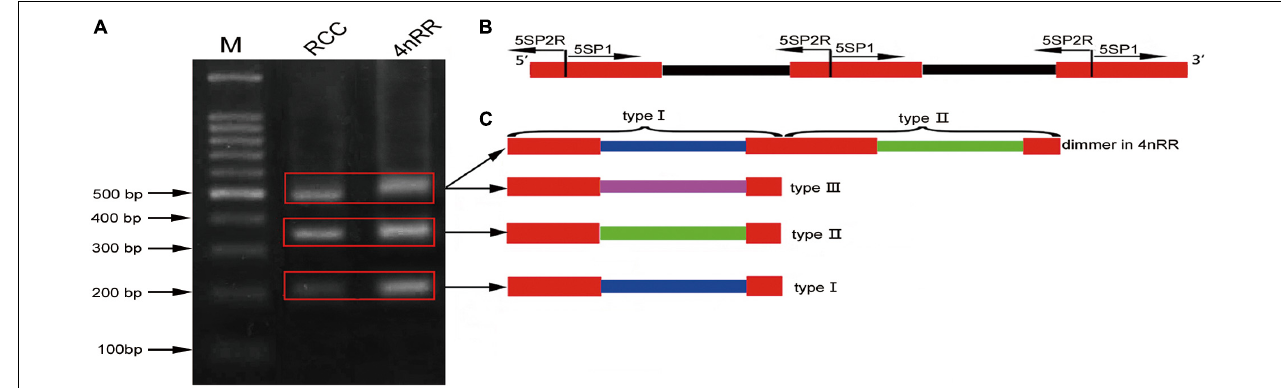
FIGURE 1 | DNA bands amplified from RCC and 4 n RR. (A) Using the primer pair 5S P1- 5S P2R, DNA fragments were amplified from RCC and 4 n RR. M, DNA ladder markers (100 bp increments); lane 1, three DNA fragments (approximately 200, 340, and 500 bp) from RCC; lane 2, three DNA fragments (approximately 200, 340, and 500 bp) from the 4 n RR; (B) Arrangement of higher eukaryotic 5S rRNA genes (red) intercalated with non-transcribed DNA segments (NTS; black); (C) Representative sequences of 5S rDNA type I, II, and III from RCC and 4 n RR; red indicate 5S rRNA genes; blue, green and purple indicate distinct NTS